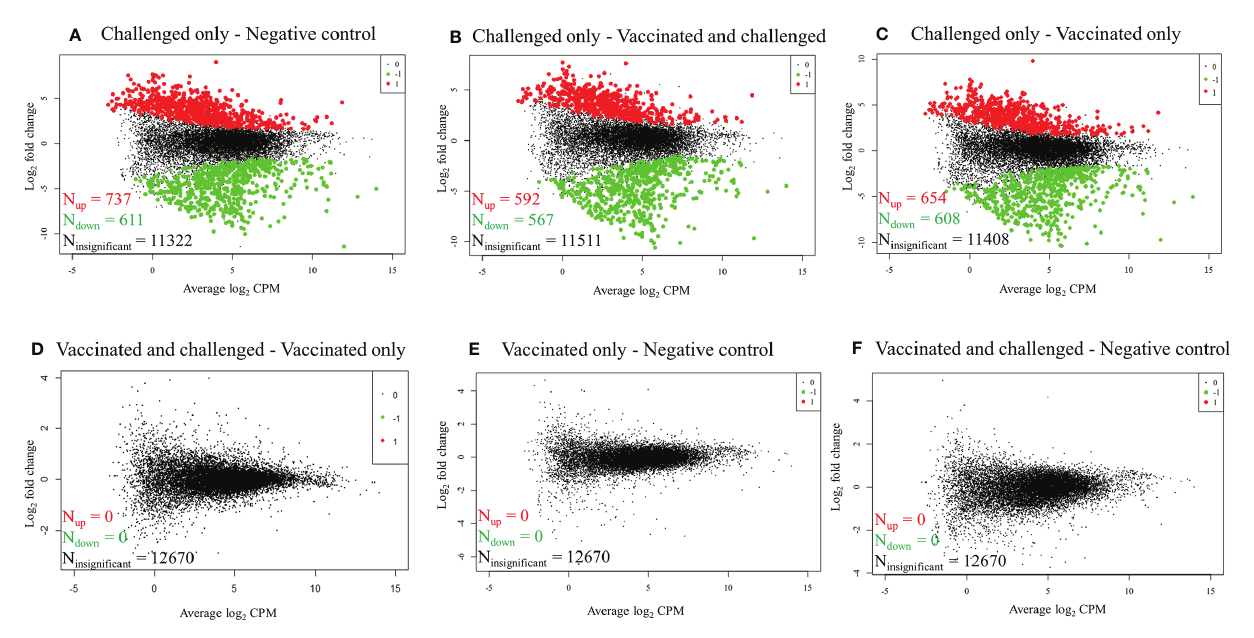
FIGURE 1 | Mean-difference plots of log 2 fold change versus log 2 CPM. (A) Challenged-only versus negative control birds. (B) Challenged-only versus vaccinated- and-challenged birds. (C) Challenged-only versus vaccinated-only birds. (D) Vaccinated-and-challenged versus vaccinated-only birds. (E) Vaccinated-only versus negative control birds. (F) Vaccinated-and-challenged versus negative control birds. N indicates number of genes, red dots and numbers indicate up-regulated genes, green dots and numbers indicate down-regulated genes and black dots and numbers represent the genes with no signi fi cant difference in transcription between the groups in each